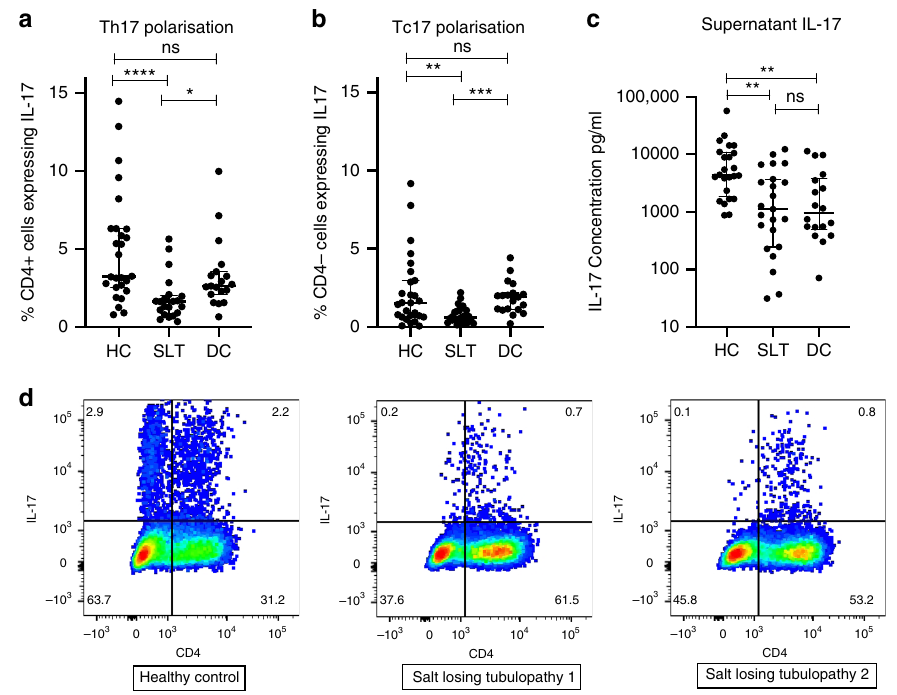
Fig. 4 IL-17 responses in salt-losing tubulopathy patients and controls. a IL-17 expression in CD4 + cells (Th17) after 1-week culture of HC ( n = 27), SLT ( n = 21), and DC ( n = 19) PBMCs stimulated with anti-CD3, anti-CD28, IL-1, IL-6, IL-21, IL23, and TGF β : HC 3.2% (2.5 – 6.3), SLT 1.6% (0.8 – 2.0), DC 2.6% (2.1 – 3.5), p = 0.0001. Groups are compared with a Kruskal – Wallis test with Dunn ’ s multiple comparison testing (shown with signi fi cance bars). Error bars represent interquartile range around the median. b IL-17 expression in CD4 − cells (Tc17) after 1-week culture of HC ( n = 27), SLT ( n = 25), and DC ( n = 19) PBMCs stimulated with anti-CD3, anti-CD28, IL-1, IL-6, IL-21, IL23, and TGF β : HC 1.5% (0.6 – 3.0), SLT 0.6% (0.3 – 1.1), DC 1.9% (1.1 – 2.2), p = 0.0005. Groups are compared with a Kruskal – Wallis test with Dunn ’ s multiple comparison testing (shown with signi fi cance bars). Error bars represent interquartile range around the median. c Supernatant IL-17 concentrations cells after 1-week culture of HC ( n = 24), SLT ( n = 23), and DC ( n = 18) PBMCs stimulated with anti-CD3, anti-CD28, IL-1, IL-6, IL-21, IL23, and TGF β : HC 4287 pg/ml (1681 – 10,487), SLT 1117 pg/ml (249 – 3709), DC 951 pg/ml (503 – 3768), p = 0.0012. Groups are compared with a Kruskal – Wallis test with Dunn ’ s multiple comparison testing (shown with signi fi cance bars). Error bars represent interquartile range around the median. d Representative FACS dot plots of IL-17 expression in CD4 + cells in a HC and 2 SLT patients. Cell proportions as percentages are documented within each quadrant. ns not signi fi cant ( p > 0.05), * p ≤ 0.05, ** p ≤ 0.01, *** p ≤ 0.001, **** p ≤ 0.0001. SLT salt-losing tubulopathy, HC healthy control, DC disease control, PBMCs peripheral blood mononuclear cells. Source data are provided as a Source data fi